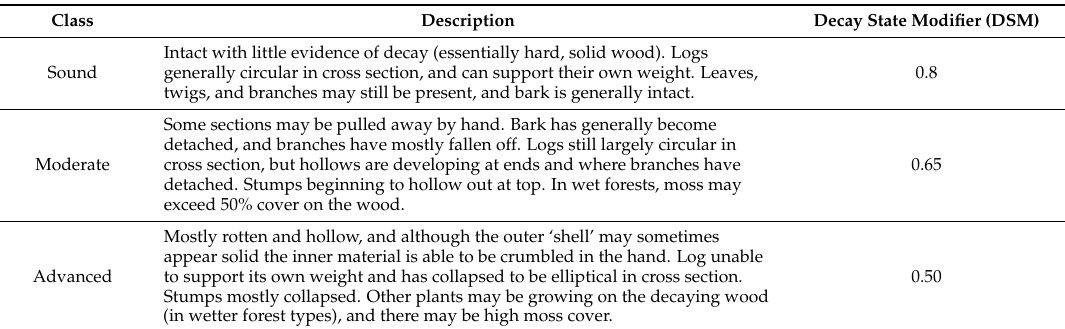
Table 1. Decay level of classes for coarse woody